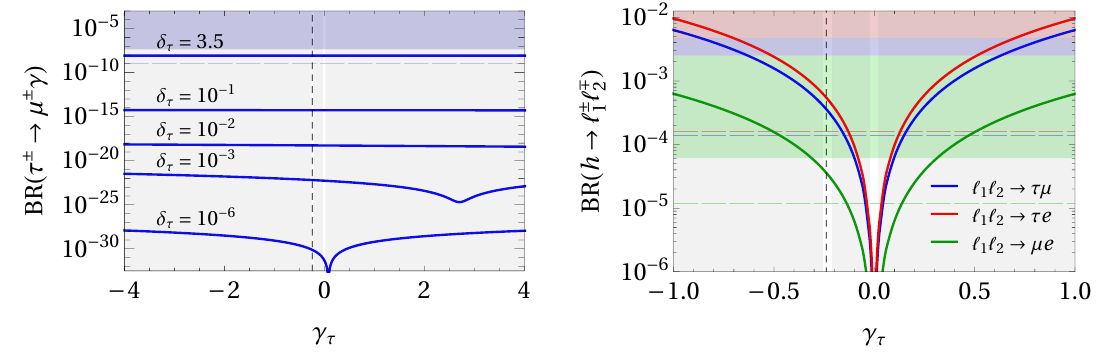
Figure 4 . Some branching ratios as functions of the Yukawa coupling γ τ . The vertical dashed lines mark the value γ = − 0 . 24 of benchmark point 1. Left panel: BR ( τ ± → µ ± γ ) versus γ τ values of δ . Right panel: the BR( h ) versus γ τ regions excluded by the inequalities (2.44).